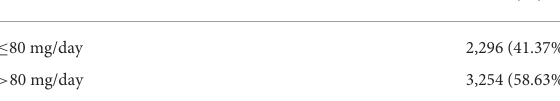
TABLE 1B Percentage of subjects with maximum recorded dose ≤ or > to 80 mg/day. Maximum recorded dose